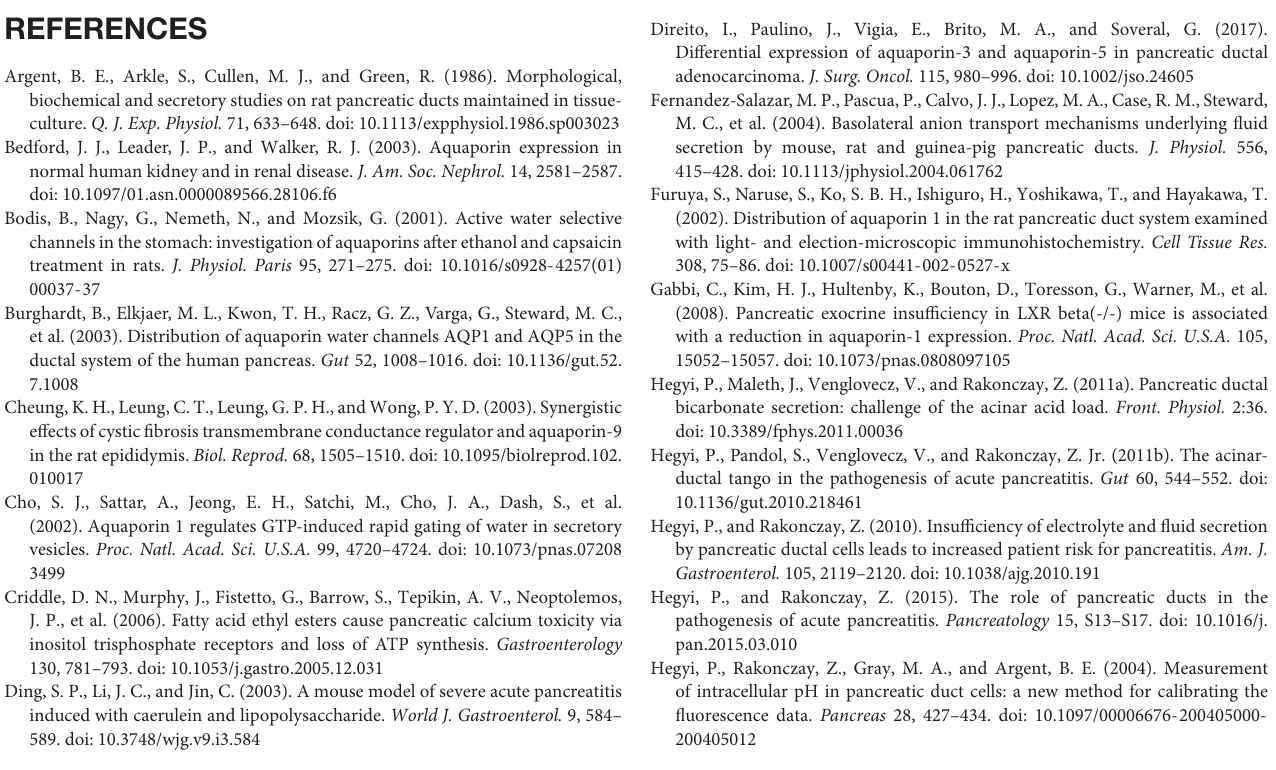
FIGURE S1 | Expression of AQP after various treatments. Capan-1 cells were treated with (A) glycochenodeoxycholic acid (GCDCA), (B) palmitoleic acid (POA), (C) palmitoleic acid ethyl ester and (D) ethanol (EtOH) for 6, 12, 24, and 48 h and the relative gene expression of AQP1 was investigated by real-time PCR. Data represent mean ± SEM of three, independent experiments. ∗ p ≤ 0.05 vs.